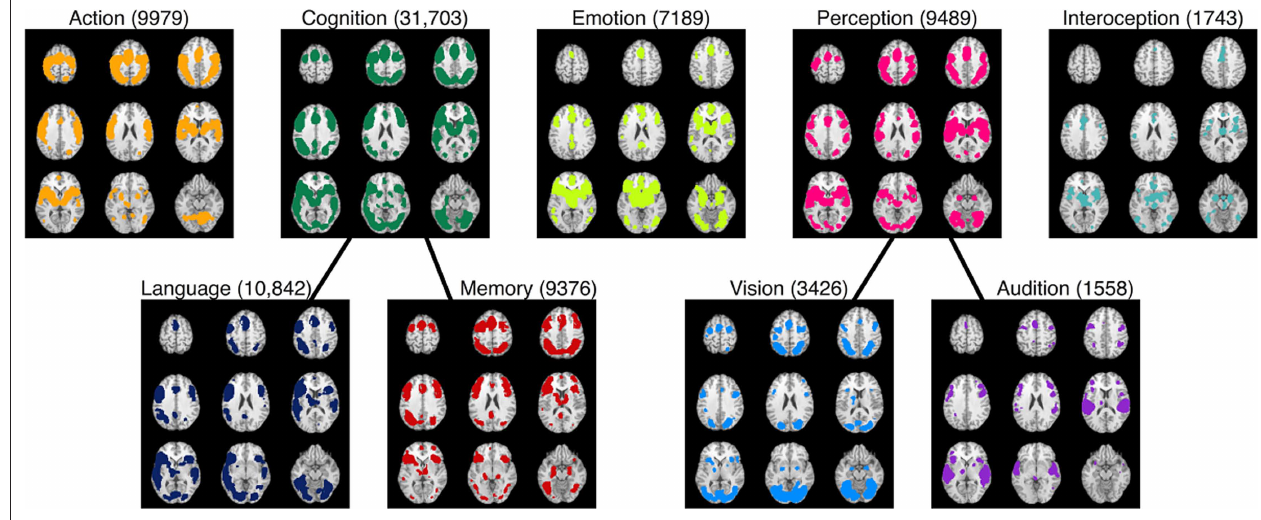
capable using the BrainMap database. Refi nement of these maps can be accomplished through high-level fi ltering and mining of the database. Results are displayed at P < 0.05, corrected. The total number of coordinates in each meta-analysis is listed after the domain heading for each map in